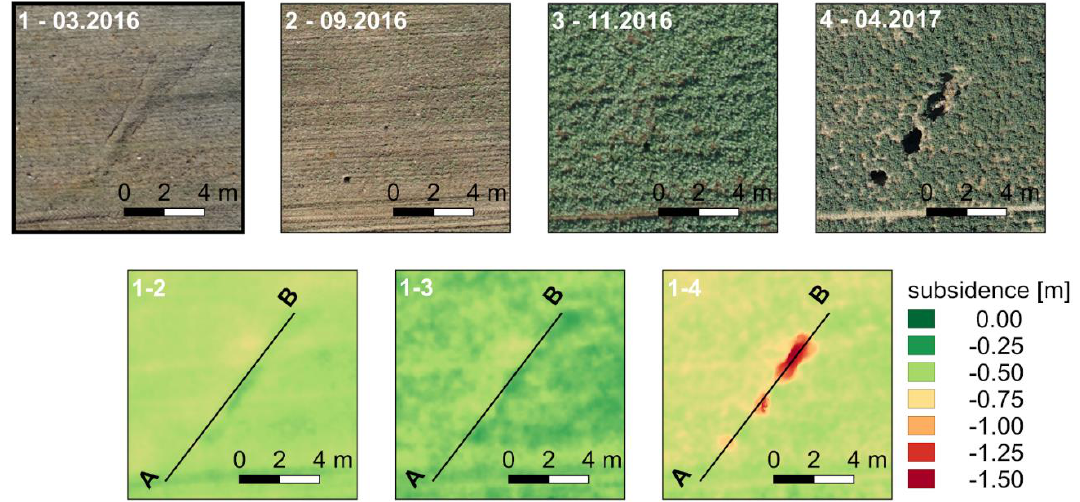
Figure 7. Development of an A–B discontinuous deformation (Piekary site).